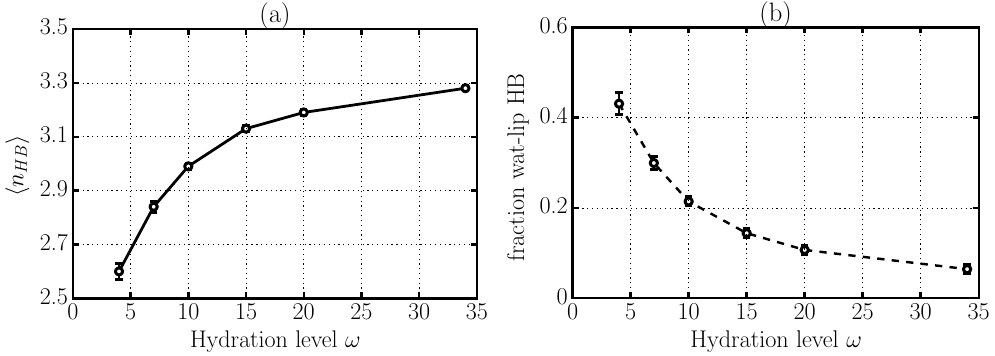
n HB of total HBs (cid:104) (cid:105)